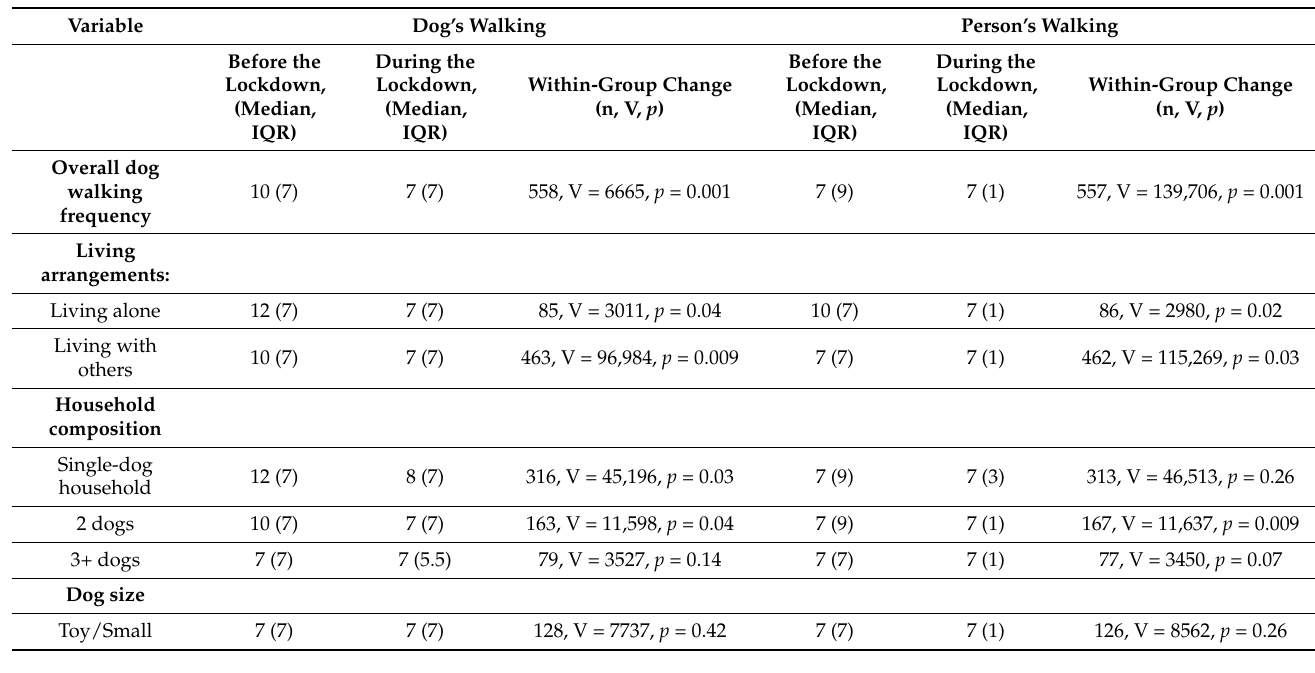
Table 1. Weekly frequency of dog’s and person’s walking before and during the COVID-19 lockdown. Within-group comparison (change in the distribution of walking frequency between before and during the lockdown) is summarised with sample size (n), Mann–Whitney paired test-statistic (V) and significance levels ( p ). Variable